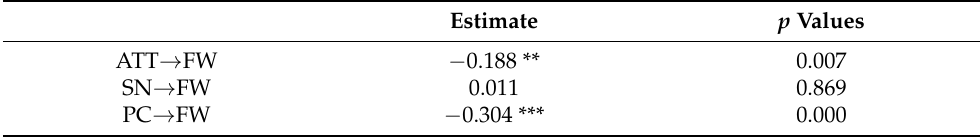
Table 4. Structure model results excluding PBC, BI and OC.